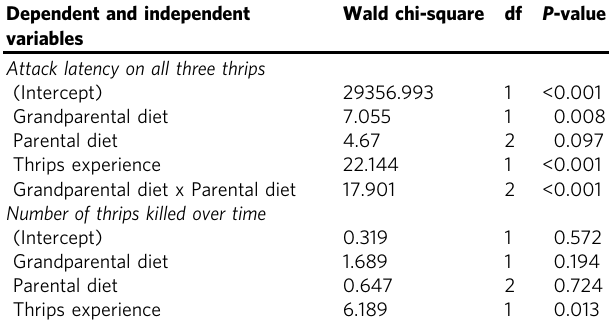
Table 2 Generalized estimating equations (GEEs) on the in fl uence of grandparental diet (pollen or spider mites), parental diet (pollen, live spider mites, dead spider mites), and thrips experience early in life (yes, no) on the attack latency on all three thrips presented (lg transformed; normal distribution, identity link function) and the number of thrips killed within 1, 3, and 5 h (Poisson distribution, log-linear link function). M-dependent working correlation structure to account for the within-subject dependency of thrips ’ rank in the sequence and time, respectively. Data are visualized in Figs. 3, 4; estimated marginal means are in Supplementary Tables 4,